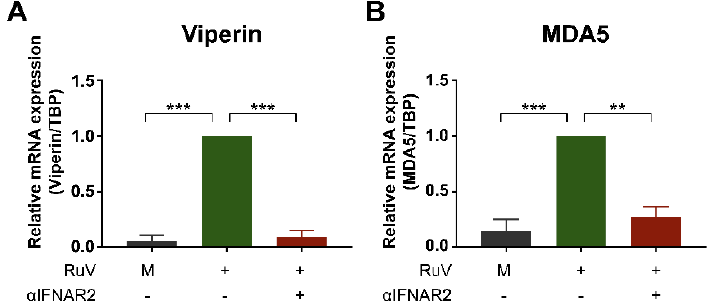
Figure 3. Anti-IFN- α / β receptor neutralizing antibody attenuates expression of RuV-induced ISGs. U373MG cells untreated (–) or pretreated (+) with an anti-IFNAR2 neutralizing antibody ( α IFNAR2) for 18 h were infected with the RuV RA27/3 strain (+) at MOI of 1.8. The antibody-untreated U373MG cells uninfected with RuV (M) were used as a reference. Cells were harvested at 24 h postinfection and subjected to quantitative RT-PCR (qRT-PCR) to detect viperin mRNA ( A ) or MDA5 mRNA ( B ). Data are shown as the mean ± SEM ( n = 3). Data were compared using one-way analysis of variance (one-way ANOVA) with Tukey’s test for multiple comparisons. **, p < 0.01; ***, p < 0.001.